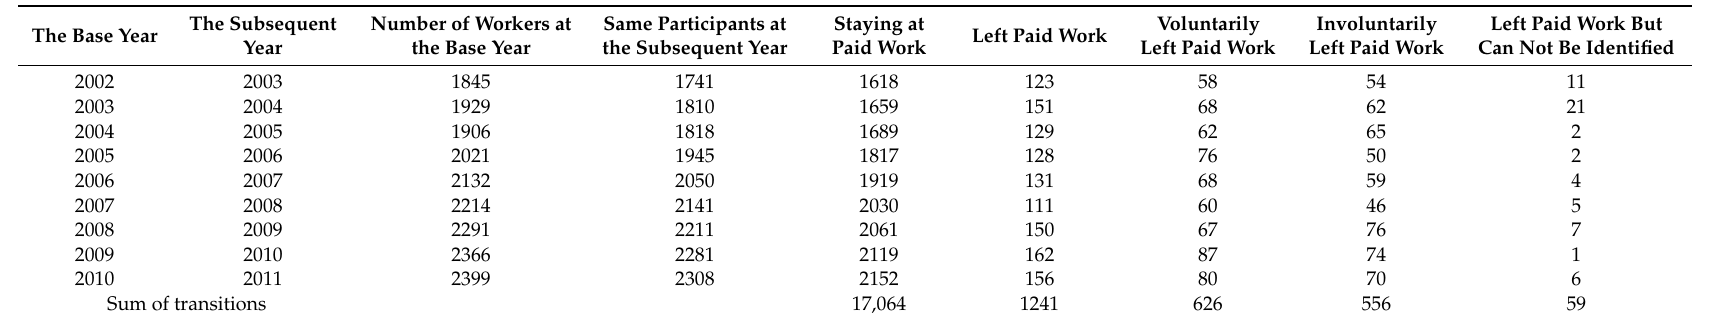
Table 1. Number of workforce transitions occurred in each year, years 2002–2011. Panel